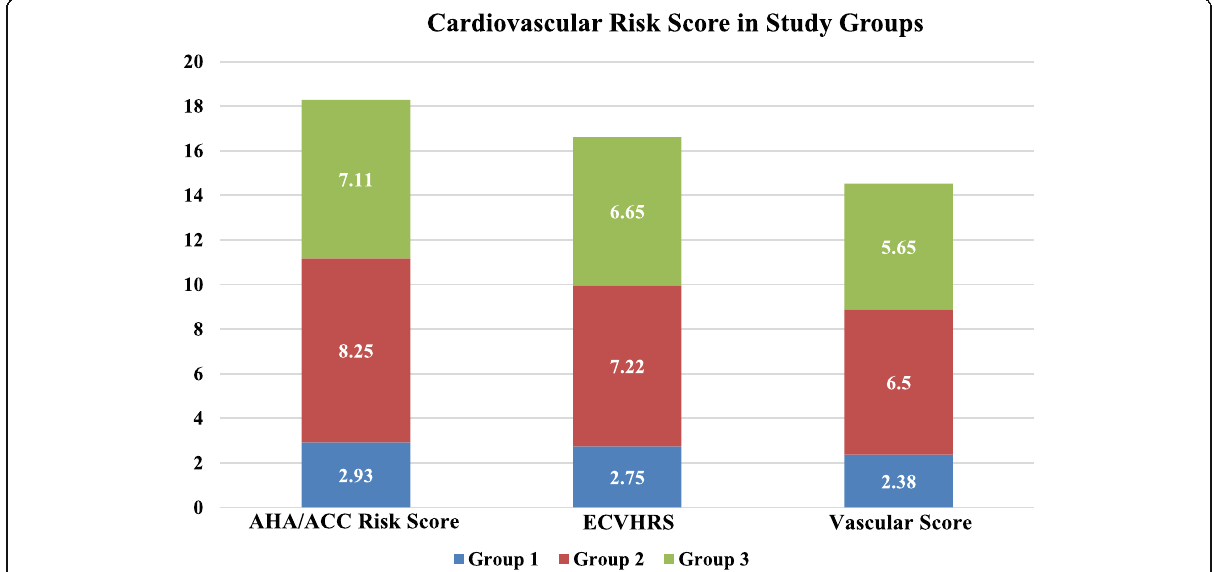
Fig. 1 Cardiovascular risk scores in the study